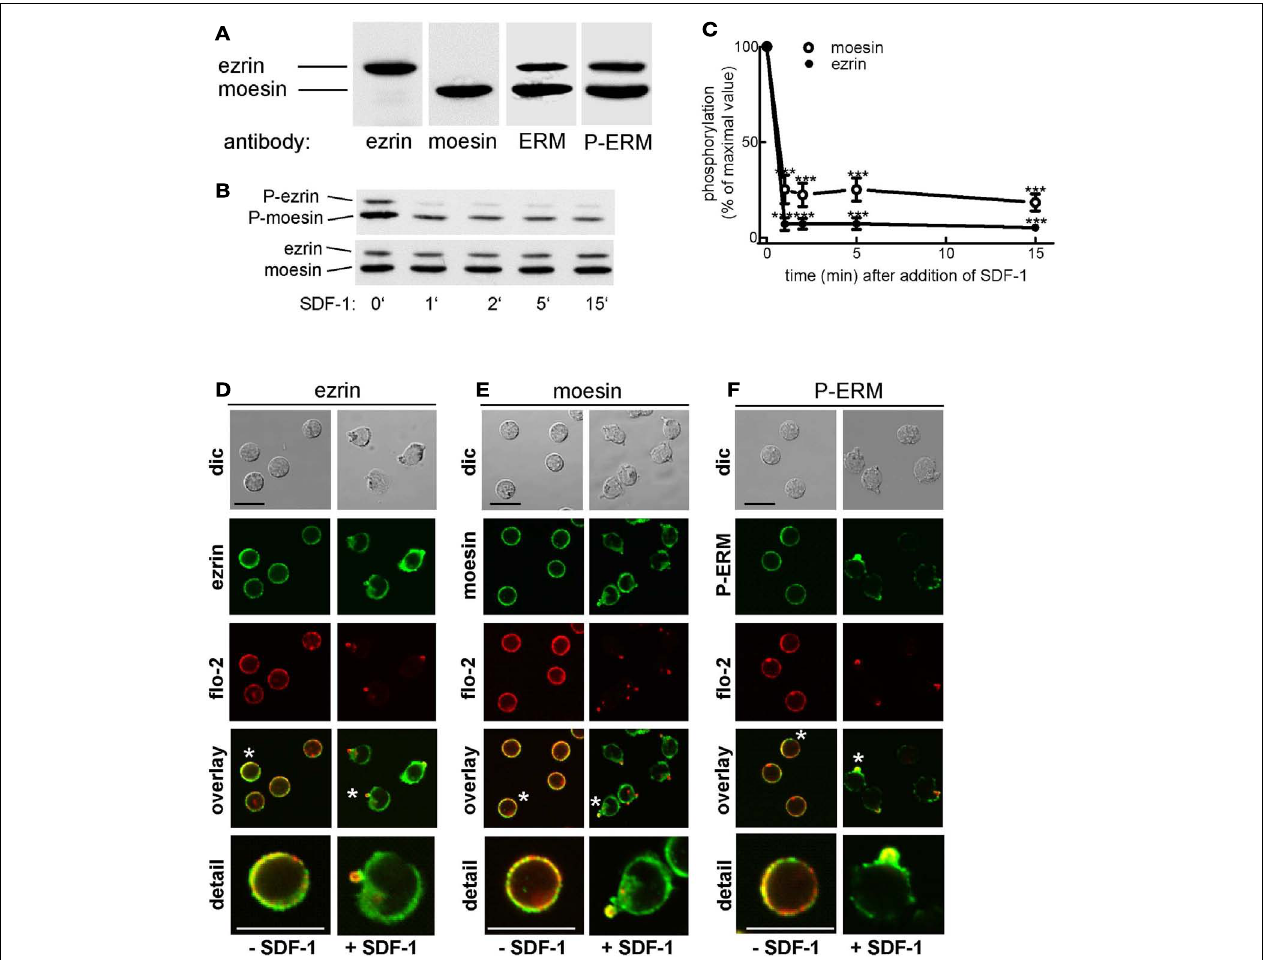
for phosphorylated moesin or ezrin, divided by values obtained for total moesin or ezrin). Mean ± SEM of four independent experiments. *** P < 0.001 for statistically significant differences to cells not exposed to SDF-1. (D–F) T cells were preincubated for 15min at 37˚C in the absence of stimuli, followed by a further incubation for 15min in the absence or presence of 40ng/ml SDF-1 as indicated.T cells were then fixed and stained for ezrin (D) , moesin (E) , or P-ERM (F) using the same antibodies as in (A) , and for flotillin-2 using monoclonal antibodies, followed by confocal microscopy (dic: differential interference contrast). Asterisks indicate cells that are shown enlarged in the panel at the bottom. Bar, 10 µ m.